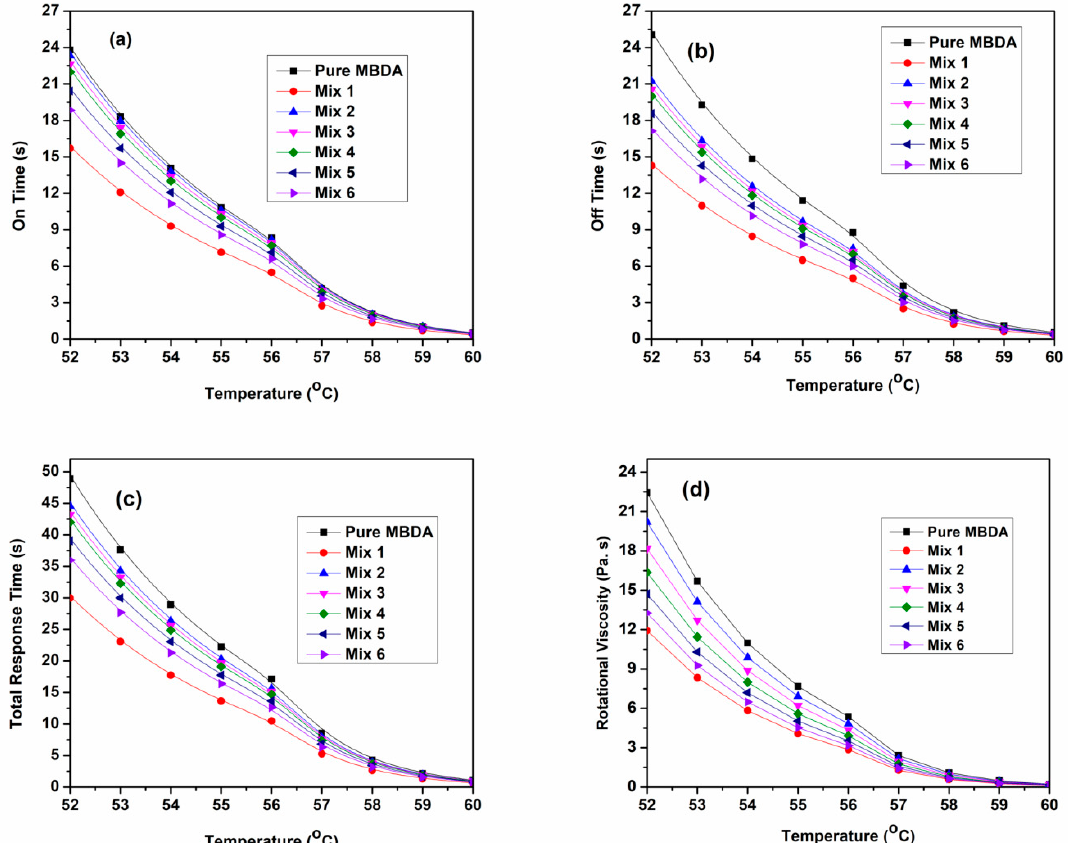
Figure 9. ( a ) Temperature dependent on time for pure nematic MBDA and its mixtures with core/shell quantum dots (Mix 1 to Mix 6) at 20 volt applied bias, 1 kHz frequency input signal; ( b ) Temperature dependent off time for pure nematic MBDA and its mixtures with core/shell quantum dots (Mix 1 to Mix 6) at 20 volt applied bias, 1 kHz frequency input signal; ( c ) Temperature dependent total electro-optic response time for pure nematic MBDA and its mixtures with core/shell quantum dots (Mix 1 to Mix 6) at 20 volt applied bias, 1 kHz frequency input signal; ( d ) Temperature dependent rotational viscosity for pure nematic MBDA and its mixtures with core/shell quantum dots (Mix 1 to Mix 6) at 20 volt applied bias, 1 kHz frequency input signal.